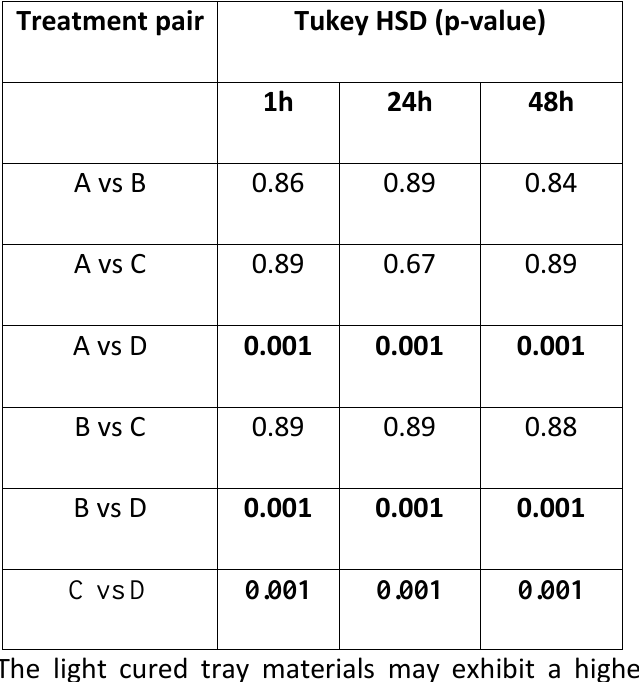
Table 2.2: Intra group comparison of change in length of the four test groups at different intervals